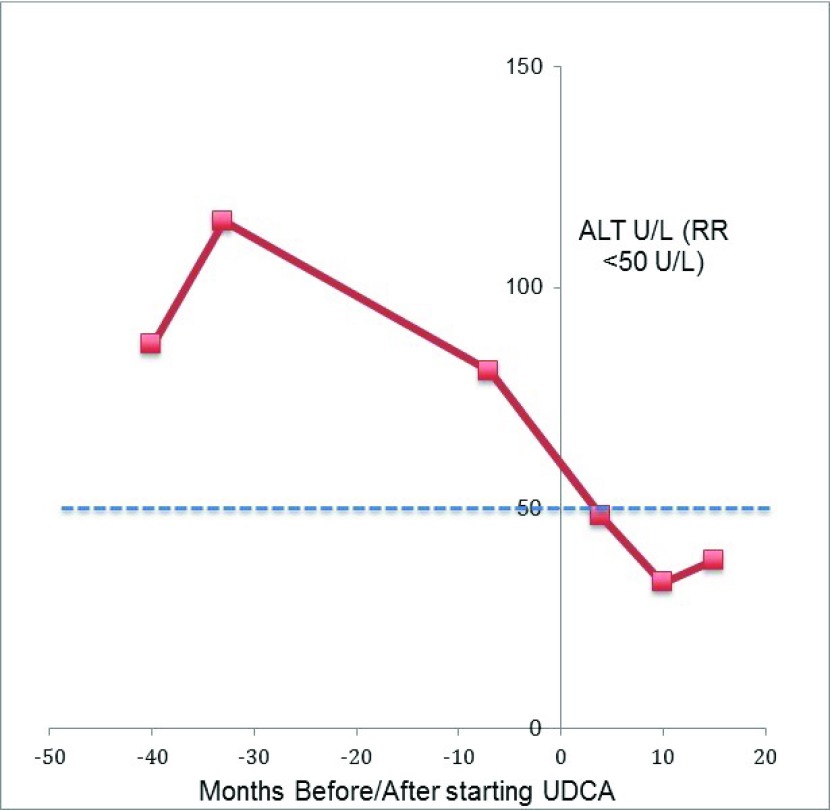
Alanine transaminase (ALT) of Case 3.This demonstrated abnormal levels before starting ursodeoxycholic acid (UDCA) that normalized following initiation of UDCA. Dotted line signifies normal value (less than 50 units/L)